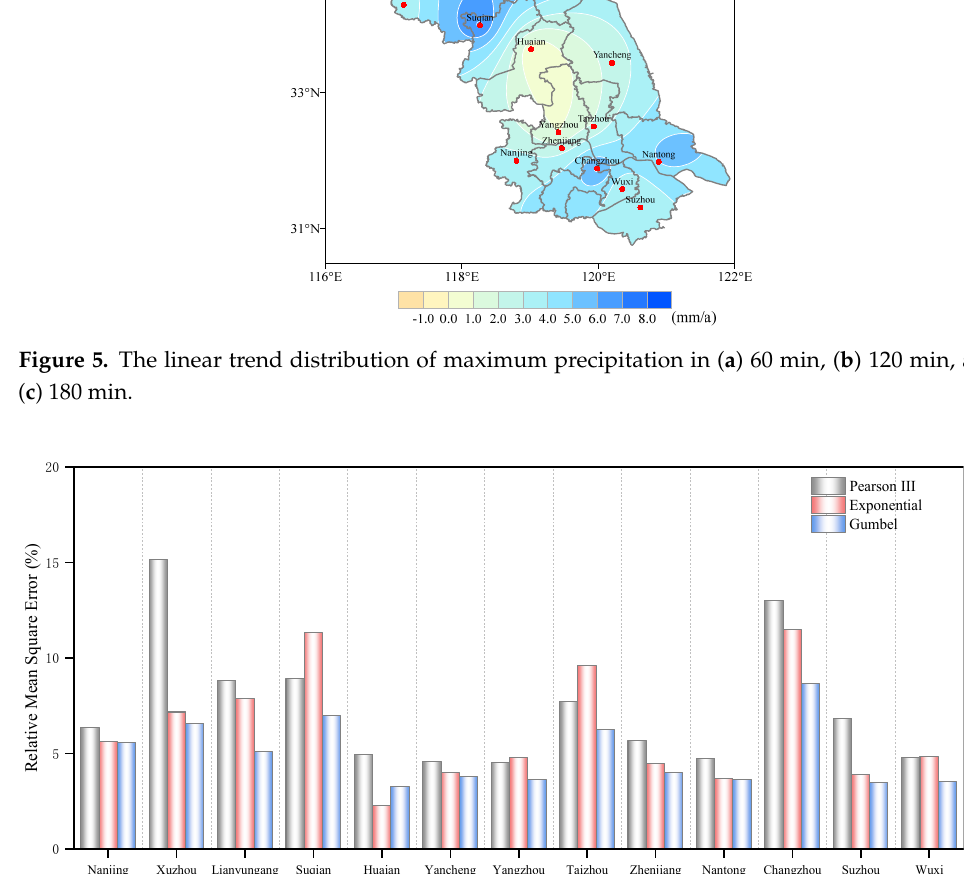
Table 1. Revised parameters of rainstorm intensity formula in 13 cities.